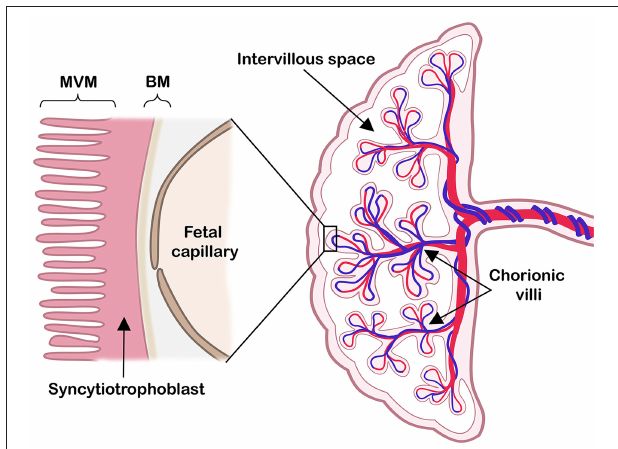
FIGURE 1 | The human placenta at term. Right: a schematic cross-section of the human term placenta with the fetal circulation in umbilical cord and chorionic villi, while maternal blood pools in the intervillous space. Left: representation of the placental barrier, which includes the syncytiotrophoblast layer and the fetal capillary endothelial cells. The two polarized syncytiotrophoblast plasma membranes, the microvillous plasma membrane (MVM) and the basal plasma membrane (BM) are indicated. Modified illustration from Nordisk Nutrition ( Lager, 2013), re-printed with permission.